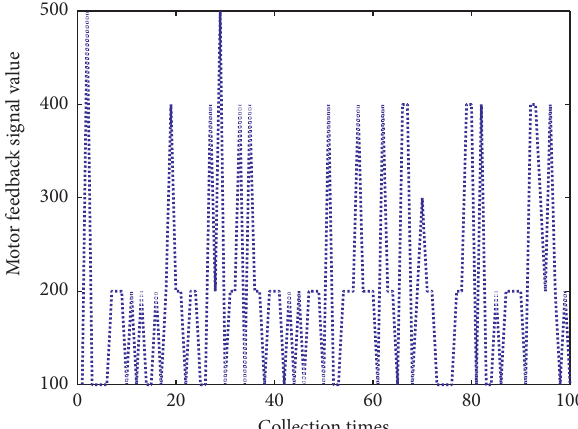
Figure 10: The simulation results of the feedback signal value of the fan with the number of data acquisitions.